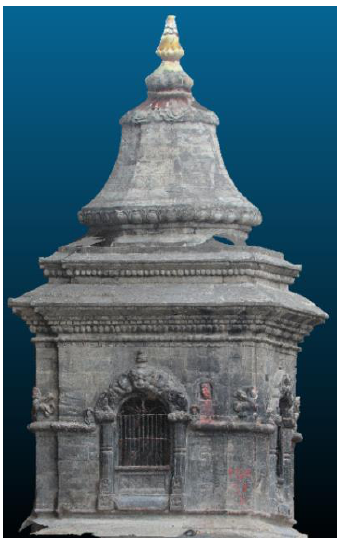
Figure 3. 3D model of a small temple in Patan Durbar Square.